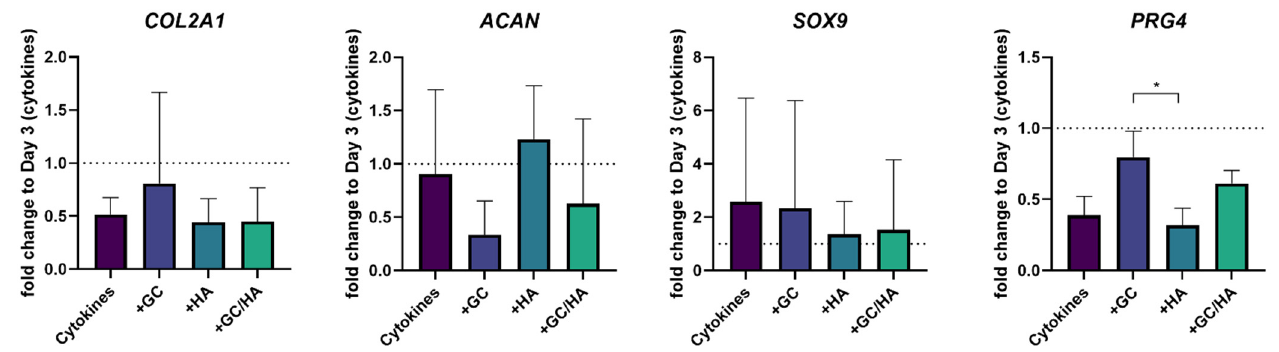
Figure 5. Expression of cartilage-specific genes; shown as fold change to day 3, when added test substances. The single asterisk indicates p < 0.05. The dotted lines represent the gene expression of cytokine-treated chondrocytes after 3 days, before test substances were added.